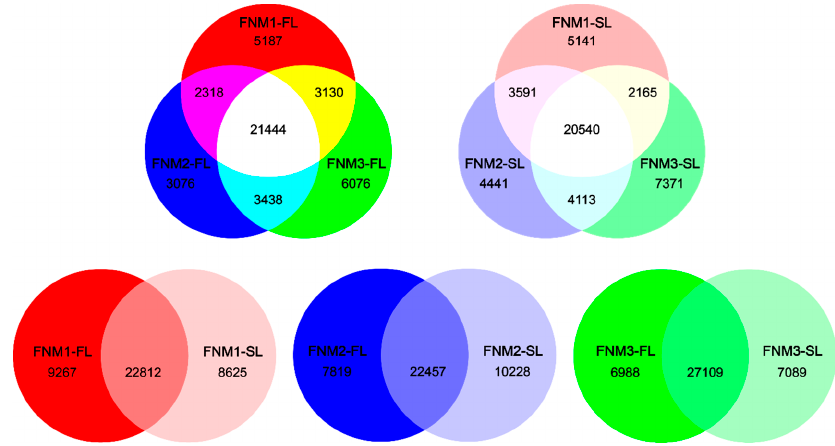
Figure 1. Genes expressed in the female fertile line (FL) and sterile line (SL) ovules at three developmental stages.